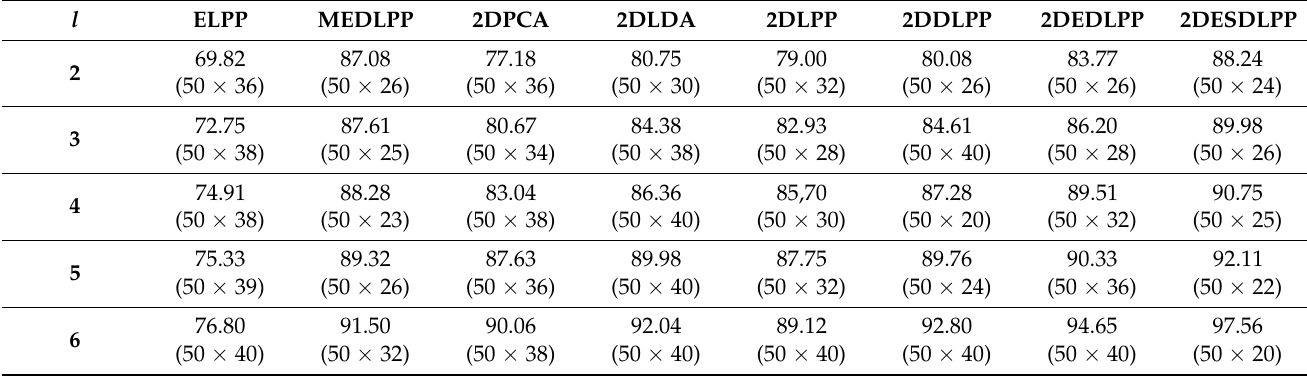
Table 6. Maximum average recognition rate (%) of 2DESDLPP and other seven comparison algorithms and the corresponding number of dimensions in AR database.